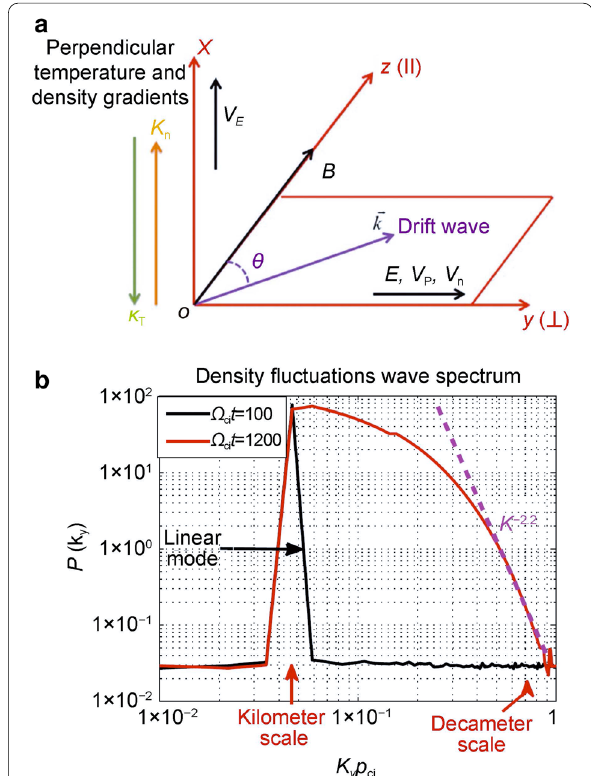
Fig. 9 a Configuration of a 2D plasma simulation used to study development of irregularities in the mid-latitude ionosphere. Primary generation is the Temperature Gradient Instability (TGI) due to opposed density and temperature gradients in the sub-auroral region. b Irregularity spatial spectrum in the y direction (propagation direction) from the simulation showing development of irregularities from cascading turbulence from the km spatial range down to decameter spatial scales that impact both GNSS scintillations and also HF space weather radar scattering (Adapted from Eltrass and Scales (2014))